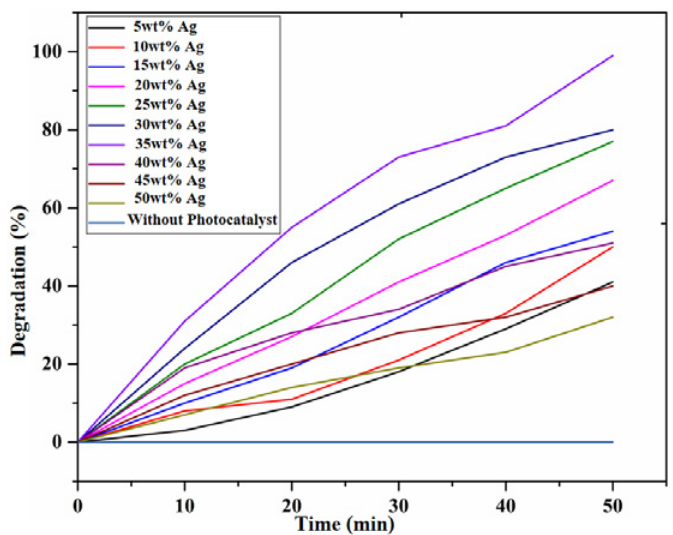
Fig. 7. Degradation curve of AO7 aqueous dye with UV light without photocatalyst and different weight ratio of Ag in Ag-TiO